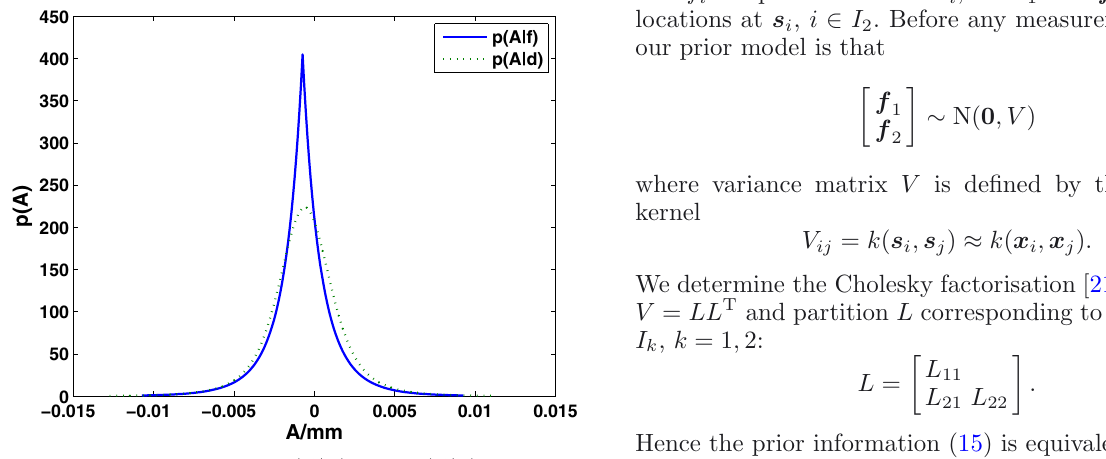
Fig. 3. Posterior densities p ( A | f ) and p ( A | d ) derived ac- cording to models (9), and (12)–(13), respectively, for eight observations generated at random with F = 0 . 0100 mm, A = 0 . 0000 mm and σ M = 0 . 002